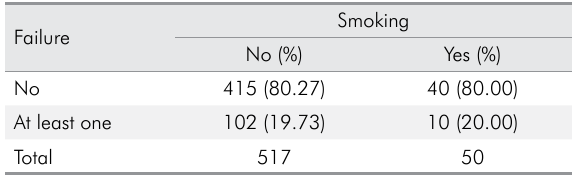
Table 4. MSI failure according to smoking